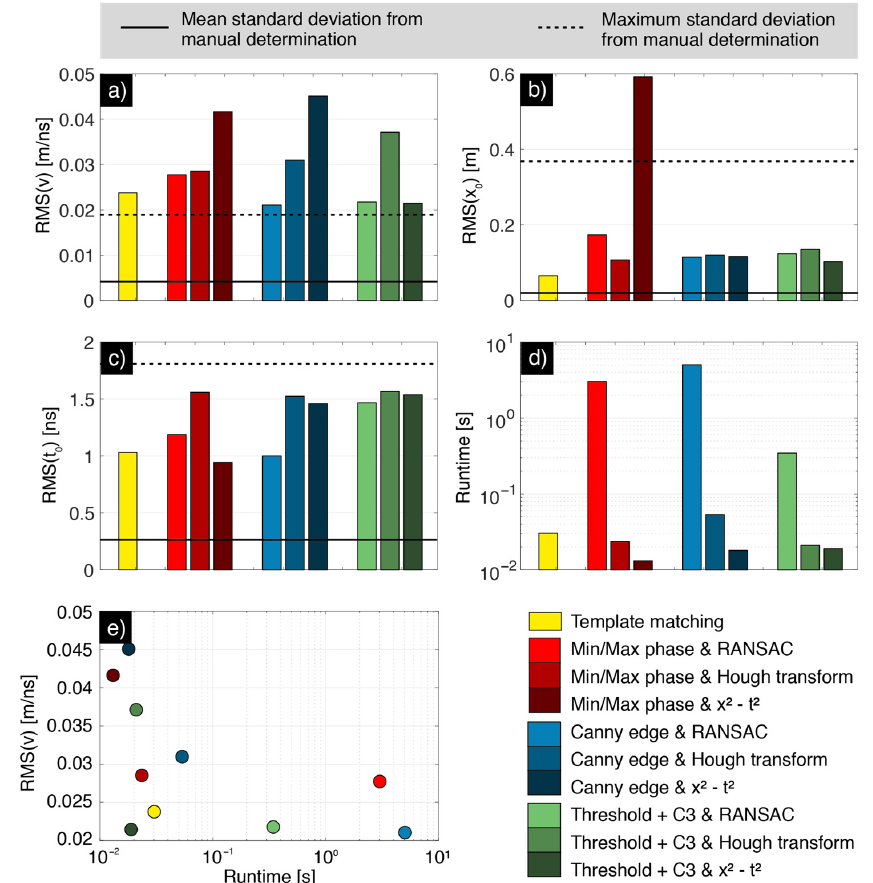
Figure 6. Comparison between manual and automatic hyperbolae fitting for all applied methods: the RMS error between manual and automatic determination are shown as bar plots for velocity ( a ), x 0 ( b ), and t 0 ( c ). The runtime for one hyperbola is shown in ( d ) as well as a plot of the velocity error versus runtime ( e ). The standard deviation from the manual fitting is calculated from the three manual picks per hyperbola.